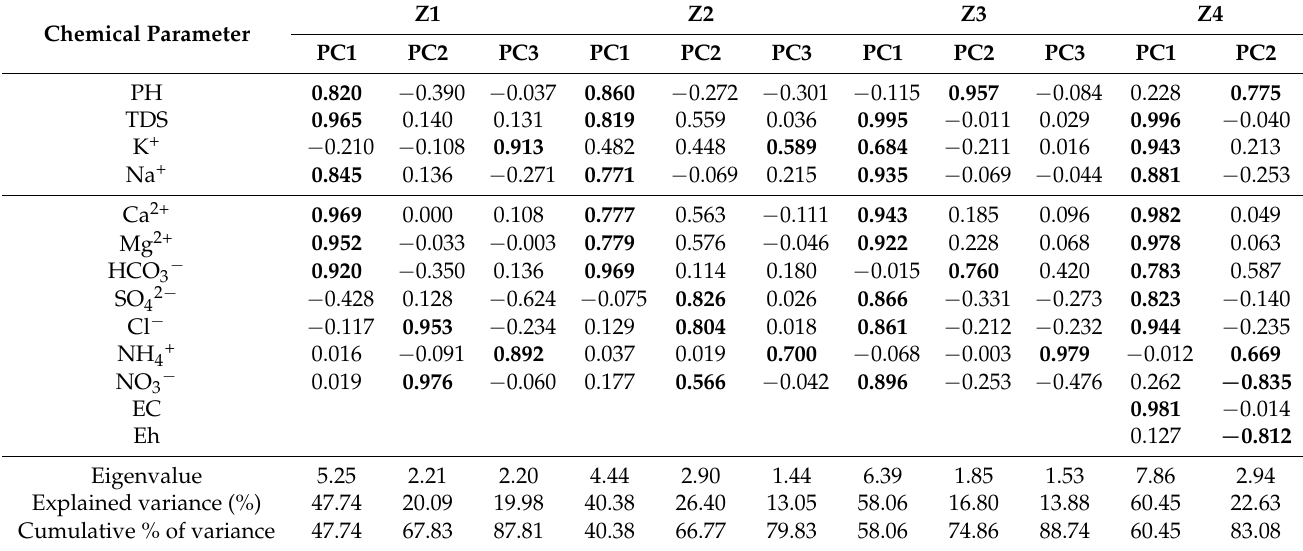
Table 3. Principal component loading for groundwater samples in four zones.